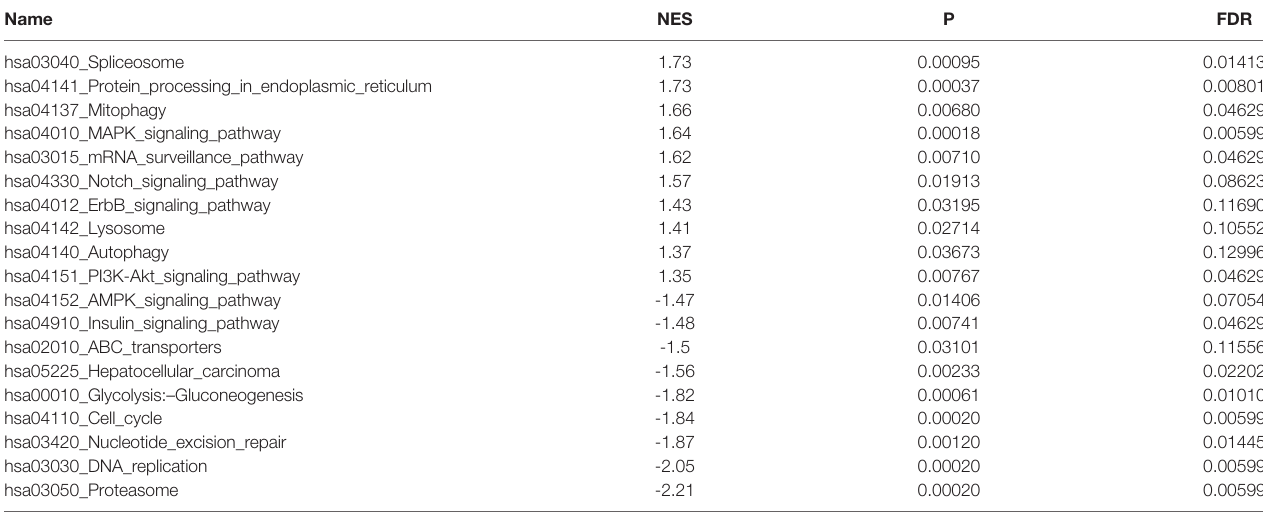
TABLE 1 | GSEA analysis based on KEGG biological